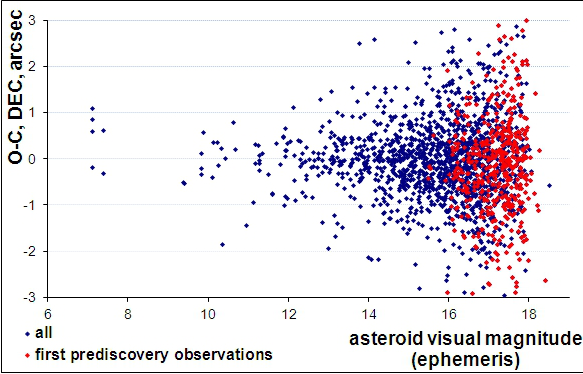
Figure 13. Distribution of O-C differences declination coordinates for all and first prediscovery asteroid observations in the catalog.